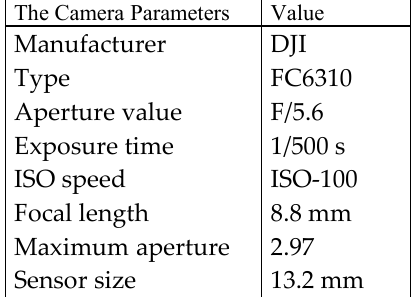
Table 1 . Parameters of the camera carried by the unmanned aerial vehicle (UAV).